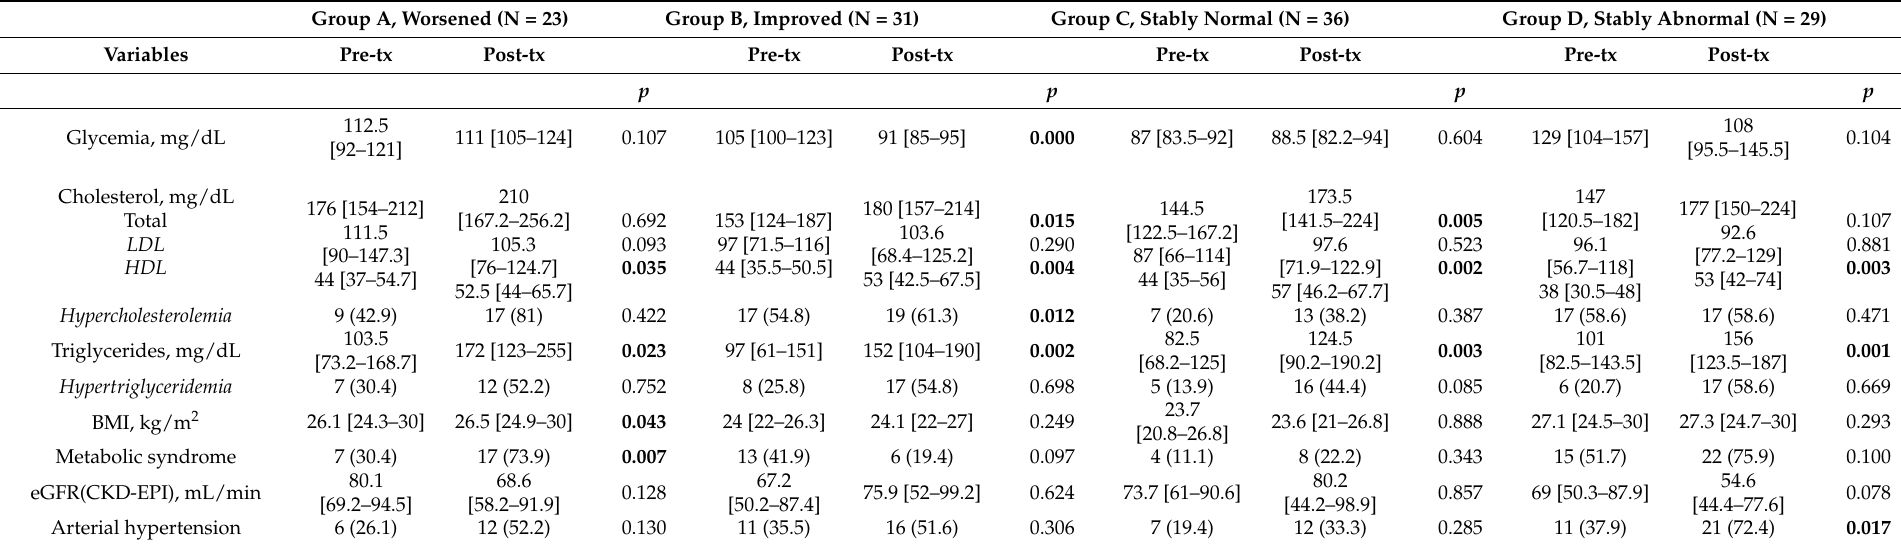
Table 4. Metabolic data before and after heart transplant in patients grouped according to changes in glucose